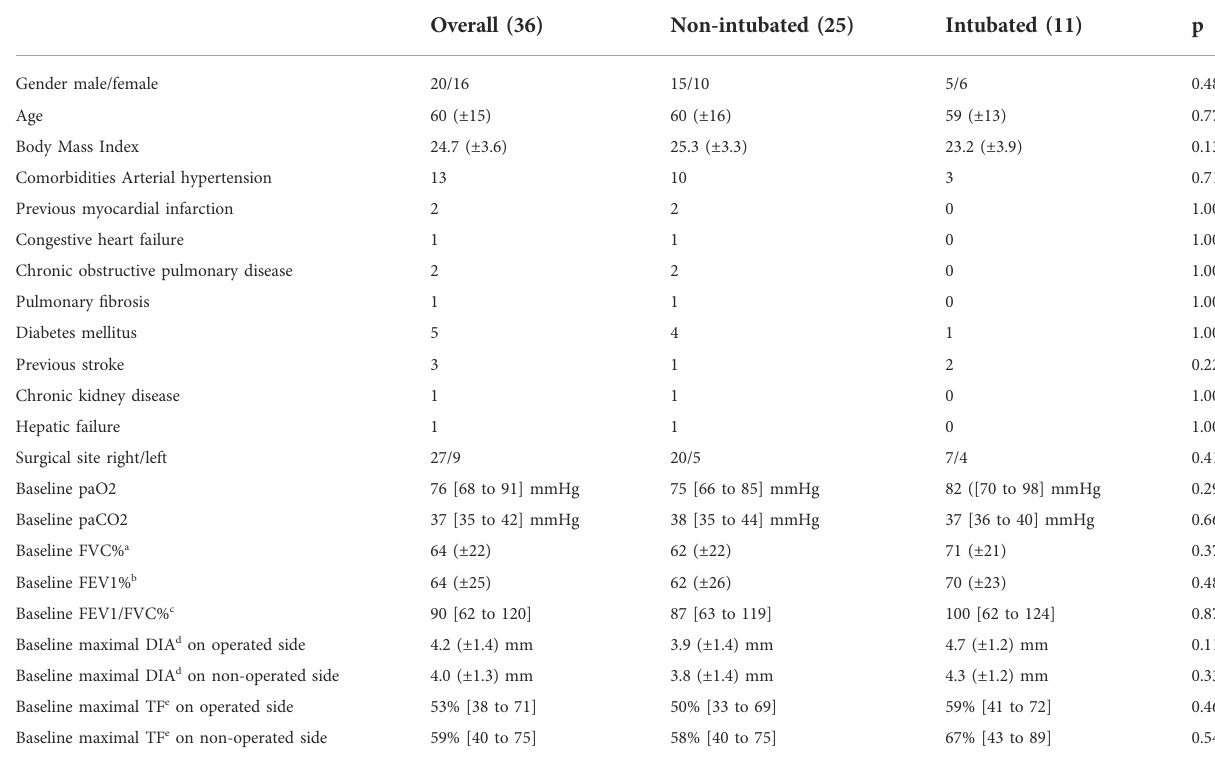
TABLE 1 Baseline characteristics.